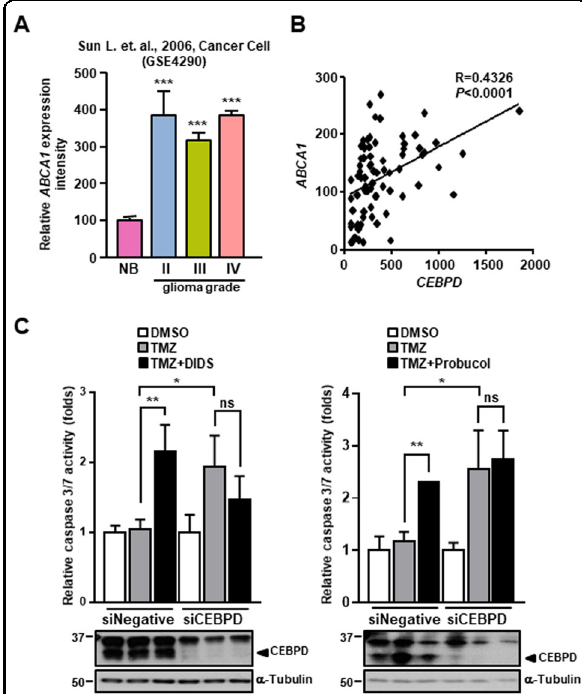
Fig. 4 ABCA1 expression is correlated with CEBPD expression and promotes against TMZ-induced cell death in GSCs. A The relative ABCA1 expressions are higher in various grades of human glioma tissues. Expression of ABCA1 was analyzed in tumor tissues of glioma patients compared with normal tissues from the GEO database. B The mRNA expression of ABCA1 positively correlates to CEBPD in glioma samples. C The CEBPD-ABCA1 axis mediates TMZ resistance in GSCs. The knockdown control (siNegative) or CEBPD- knockdown (siCEBPD) U87MG cells were cultured in stem cell medium for 2 days to form spheroids, pretreated with ABCA1 antagonists (400 μ M DIDS and 10 μ M Probucol) for 24 h, and then treated with 50 μ M TMZ for 72 h. The caspase 3/7 activity was detected by the Caspase-Glo ® 3/7 Reagent. The summary data are presented as the mean ± SEM; the numbers in the bars represent the sample sizes; one- way ANOVA; * p < 0.05, ** p < 0.01, *** p < 0.001, ns: no signi fi